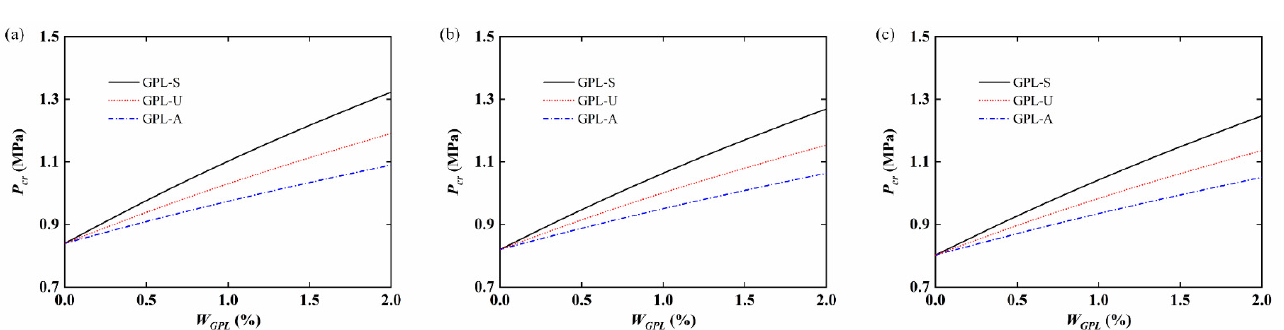
Figure 9. Variations in critical pressure of ring-stiffened porous GPLRC cylindrical shells with weight fractions for different GPLs distributions ( a ): PD-S; ( b ): PD-U; ( c ): PD-A.